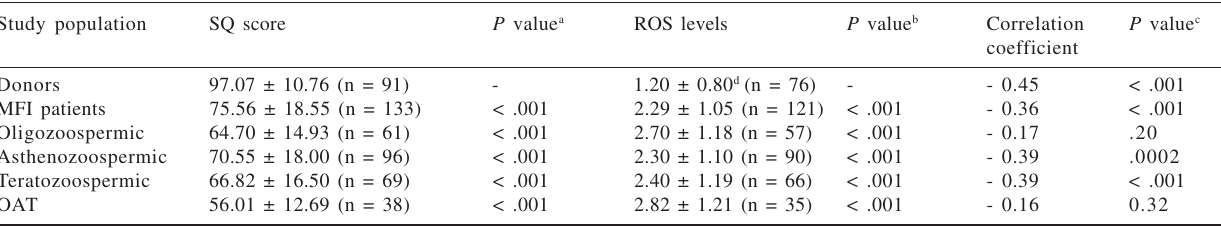
Table 1 - Reactive oxygen species (ROS) levels in donors and male factor infertility (MFI) patients and its correlation with semen quality score